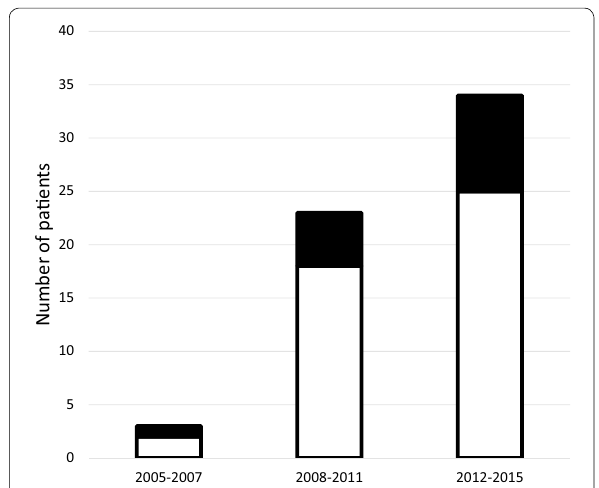
Fig. 1 Individual cases of invasive pulmonary aspergillosis (solid bars) and Aspergillus spp. colonisation (open bars) reported from 2005